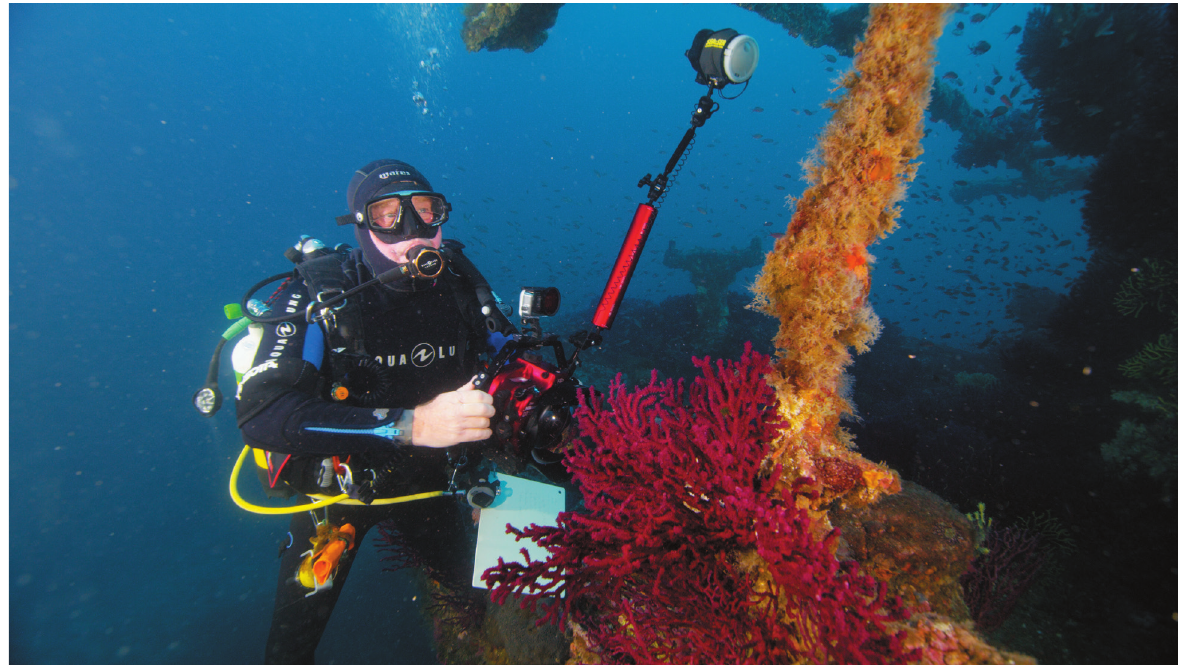
Fig. 3. Patrice Francour diving on the wreck Donator at Porquerolles (France) in July 2018; © Jerome Espla